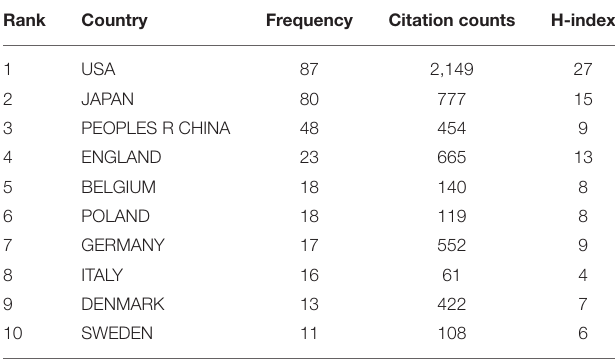
TABLE 2 | The list of top 10 countries contributed to the publications on NMU researches from 1987 to